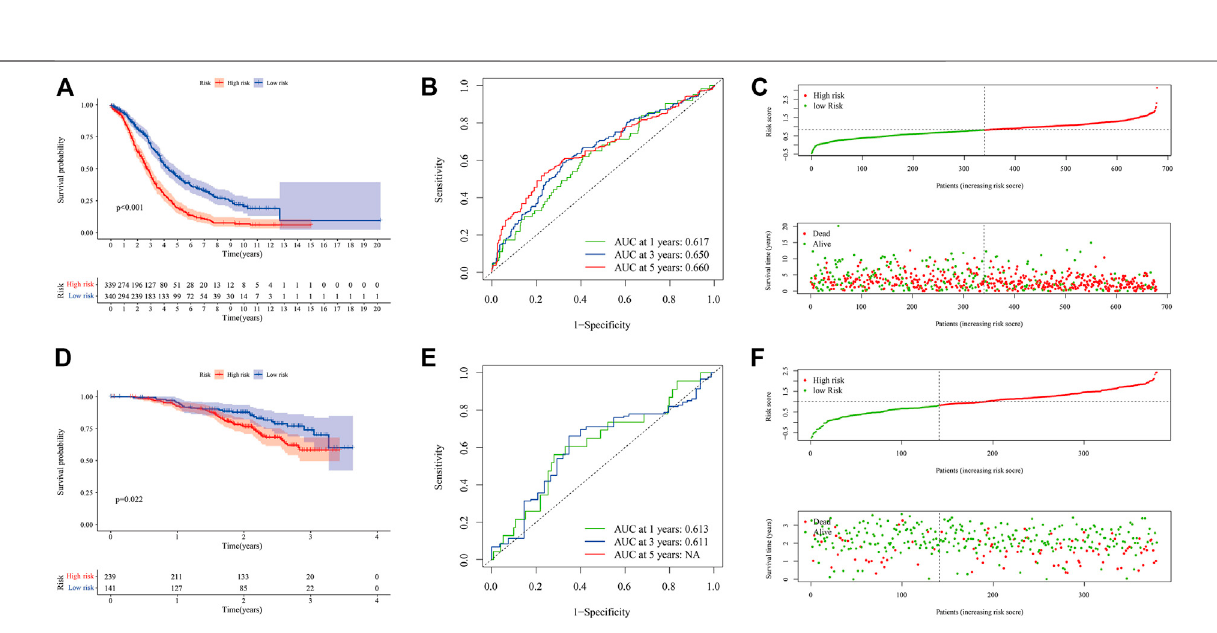
Frontiers in Cell and Developmental Biology |